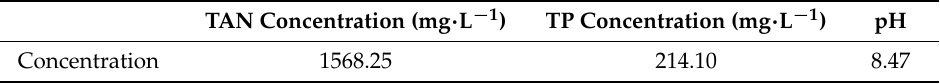
Table 1. Physicochemical properties of the biogas slurry for the